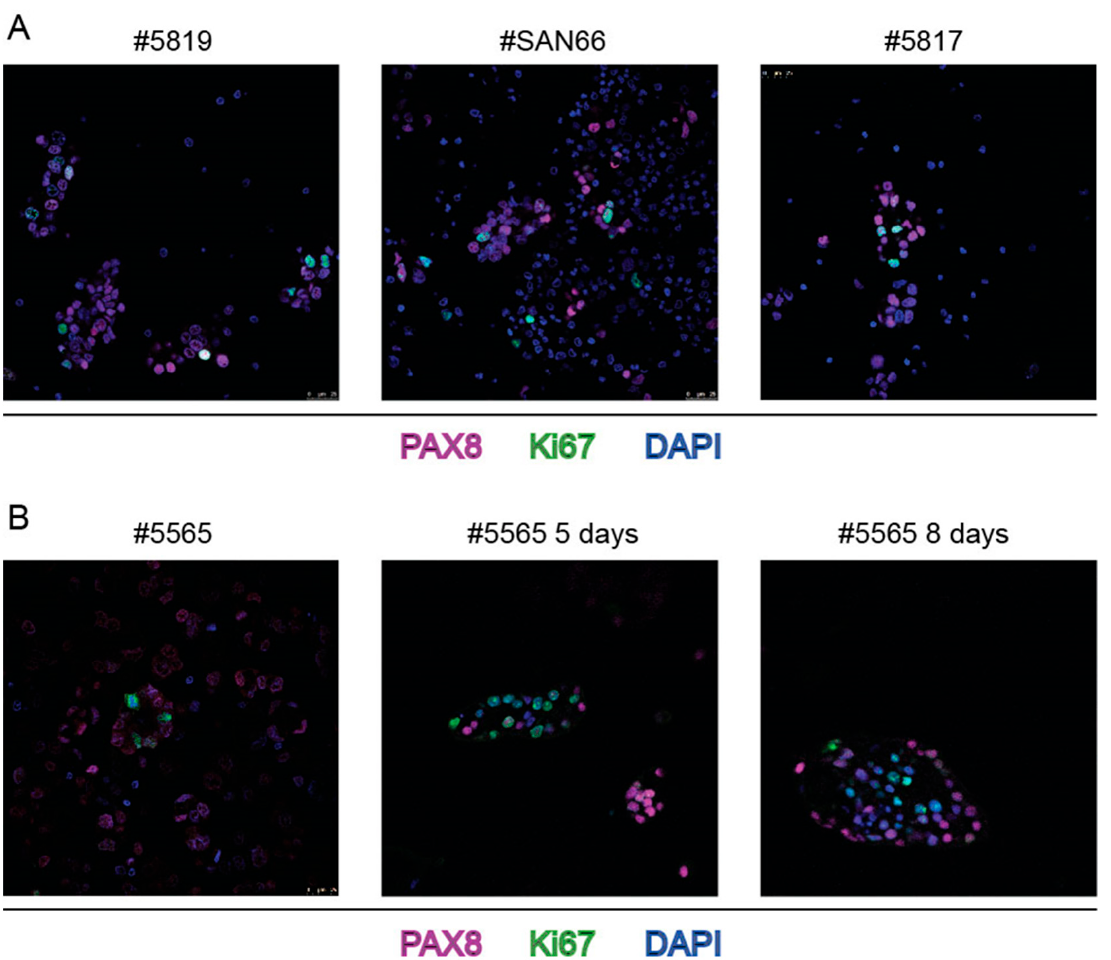
Figure 3. Ki67 staining of spheroids from bulk ascites samples combined with staining with PAX8 MAb and DAPI. ( A ) three independent cases; ( B ): ascites sample #5565 cultivated in Matrigel for 5 and 8 days. Numbers on top of each panel correspond to the Profiling protocol numbers of the collected ascites. Details of each #case are in Supplementary Table